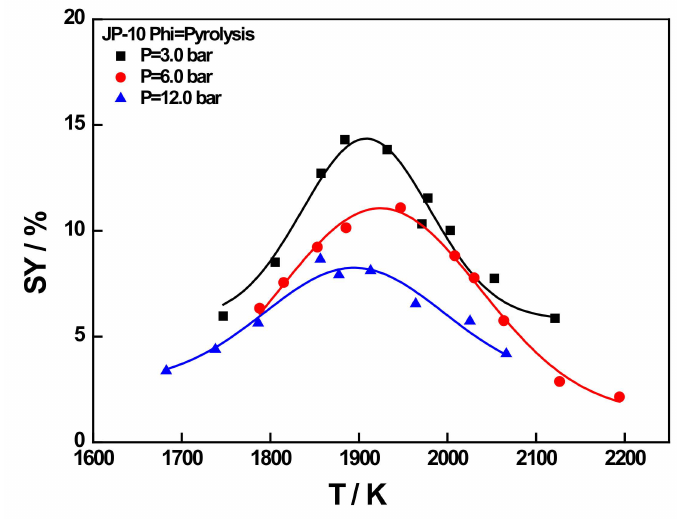
Figure 9. Fitted (lines) and experimental (symbols) results of soot yield as the function of temperature for JP-10 under different pressures in the pyrolysis condition.